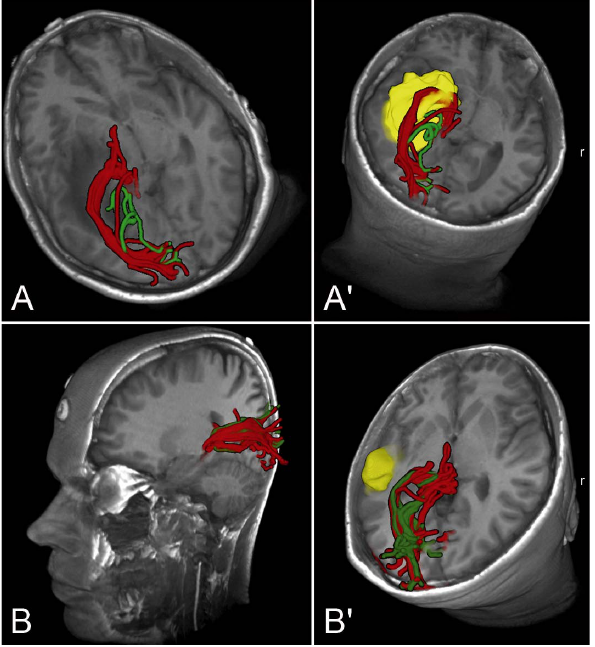
Figure 2. 3-D models of T1-weighted MR-images with overlay of HARDI + CS-(red), and DTI-(green)-based tractography of the optic radiation presented as hulled fiber objects. A + A 9 : Case presentation (case 7): Case of a large temporo-mesial GBM of a 45 year- old male patient, showing the marked differences of HARDI + CS-, and DTI-based fiber objects in case of a large, high-grade tumor. A: axial oblique view. A 9 : Axial oblique view. Tumor manually segmented in yellow. B + B 9 : Case presentation (case 6): 35 year-old male patient with small diffuse astrocytoma. Less remarkable differences of tractography results in case of this smaller, low-grade tumor. B: Left sagittal oblique view. B 9 : Axial oblique view. Tumor manually segmented in yellow.